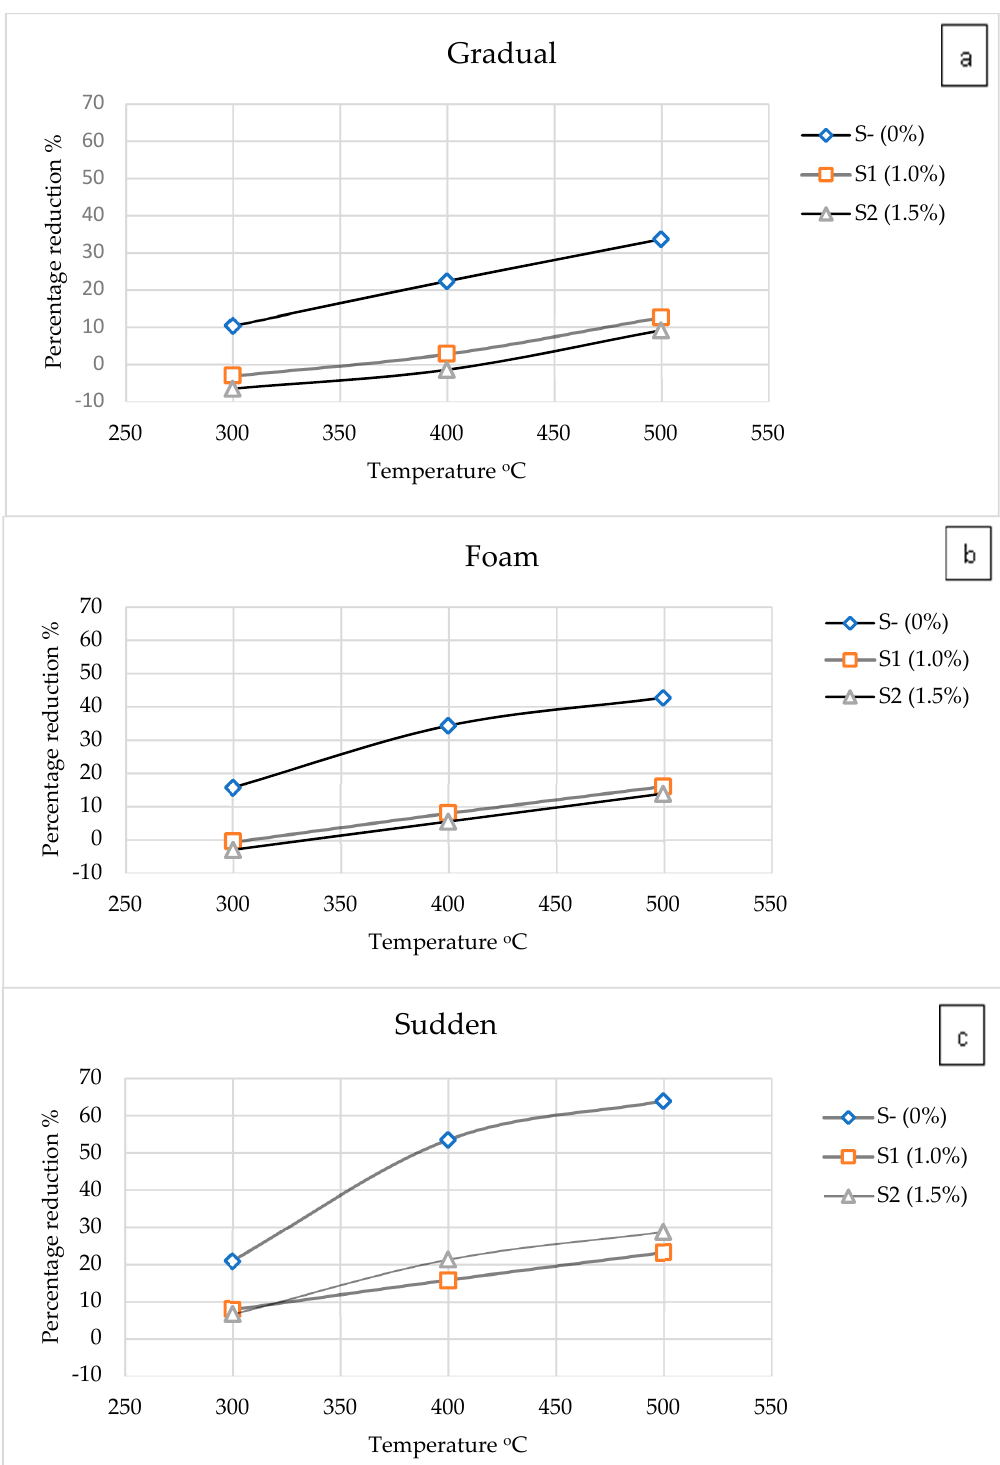
Figure 6. Percentage reduction in compressive strength concerning all burning temperature and various (RPC) specimens: ( a ) Gradual cooling; ( b ) Foam cooling; and ( c ) Sudden cooling.